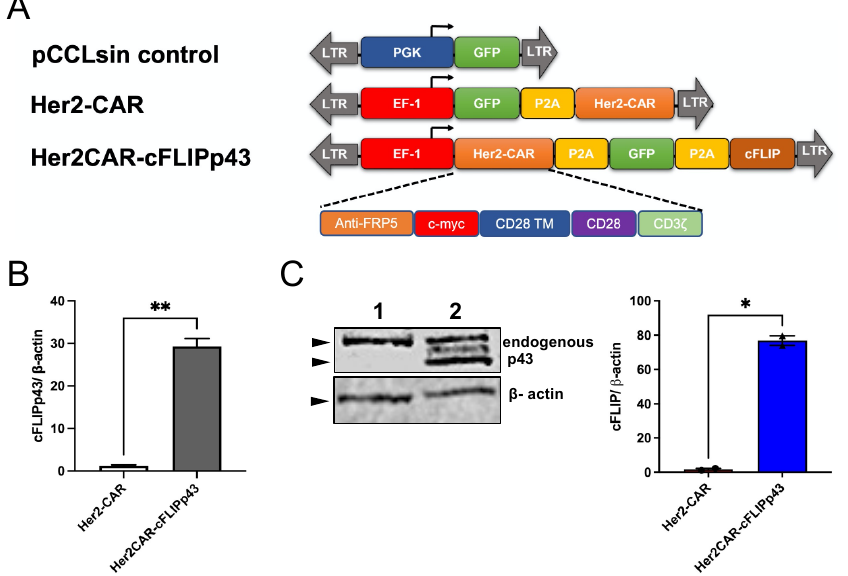
Figure 1. Design of anti-apoptotic c-FLIPp43 CAR T cell cassettes and validation of expression in human T cells. ( A ) Design of lentiviral constructs pCCLsin control, Her2-CAR and Her2CAR-cFLIPp43. pCCLsin control expressing green fluorescent protein (GFP) served as the experimental control for all functional studies. Her2-CAR construct is a c-myc-tagged, second-generation Her2-CAR linked to GFP via porcine teschovirus-1 2A (P2A) peptide. Anti-apoptotic gene c-FLIPp43 was linked to Her2-CAR via P2A peptide to generate Her2CAR-cFLIPp43 construct. LTR, long terminal repeats; PGK, phosphoglycerate kinase promoter; GFP, green fluorescent protein; EF-1, elongation factor-1 promoter; TM, transmembrane domain. ( B ) c-FLIP expression at mRNA level was measured